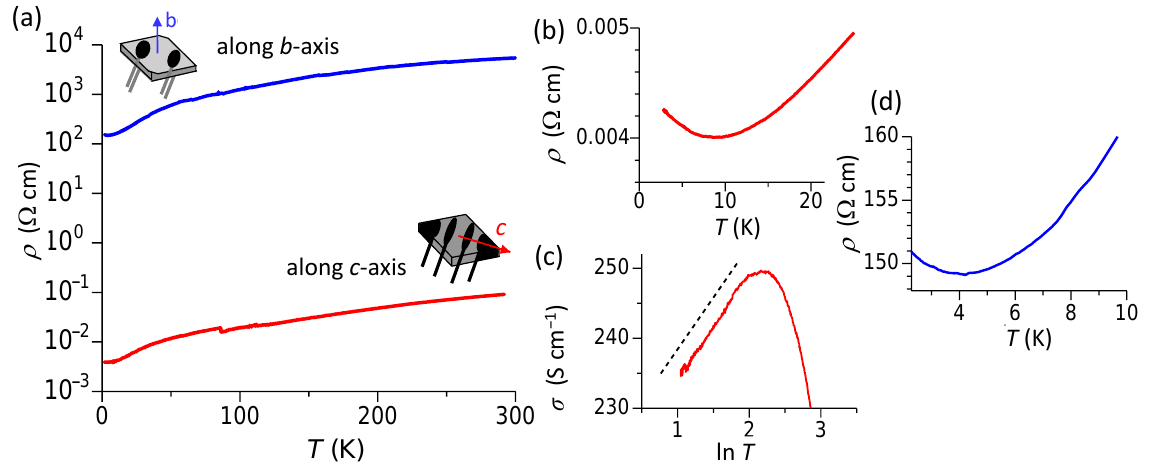
Figure 4. ( a ) The temperature ( T ) dependence of the electrical resistivity ( ρ ) of κ -BO2 in the direction parallel (sample #1, along c -axis) and perpendicular (sample #2, along b -axis) to the 2D layer. ( b ) Intralayer resistivity of the sample #1 in the low temperature region. ( c ) Intralayer conductivity of the sample #1 as a function of ln T . The broken line represents the relationship of σ ∝ ln T . ( d ) Interlayer resistivity of sample #2 in the low temperature region.